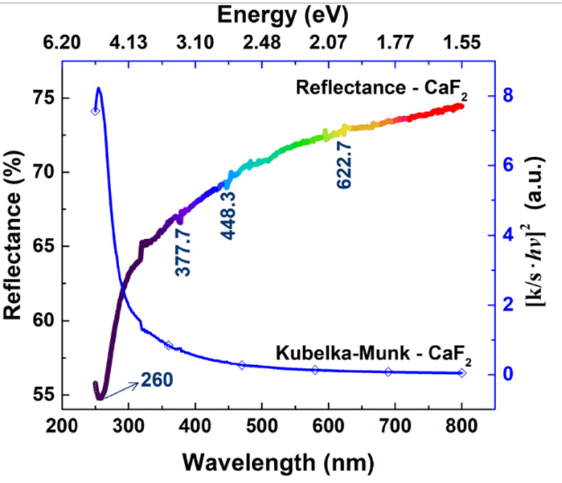
Figure 3. Diffuse reflectance UV-Vis spectrum of part -CaF 2 (bottom and left axes) and its corresponding K-M transformation (upper and right axes).